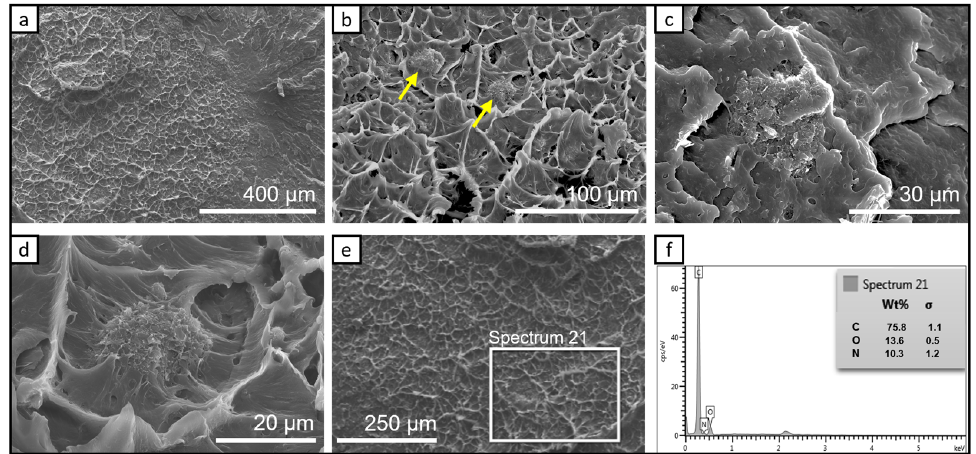
Figure 3. Representative SEM micrographs of bio-PA1010 filled with 4% C500 GNP: low magnification image showing the rough surface of the sample ( a ); detailed view of the rough surface, with flakes and graphenic aggregates marked with yellow arrows ( b , c ); and high magnification image of graphenic aggregates surrounded by flakes ( d ); the area selected for the EDS analysis ( e ); and the EDS spectrum and elemental composition of the selected area ( f ).